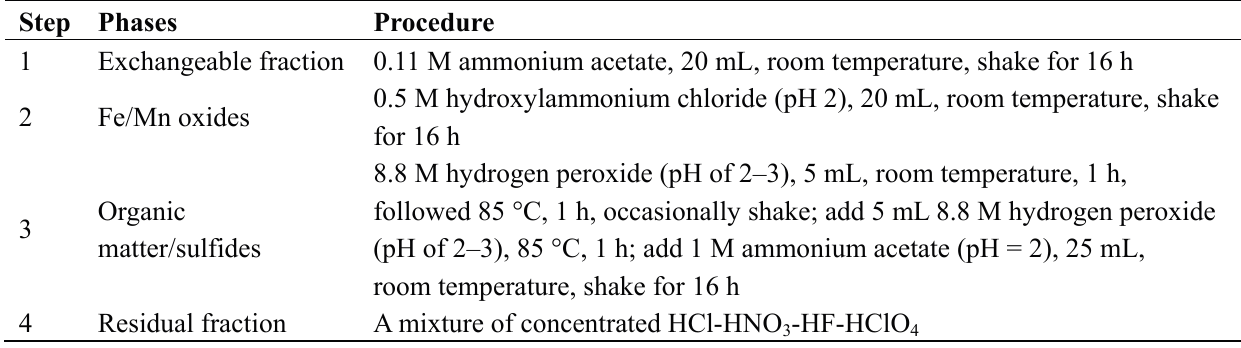
Table 1. Sequential extraction scheme for heavy metal fractionation in